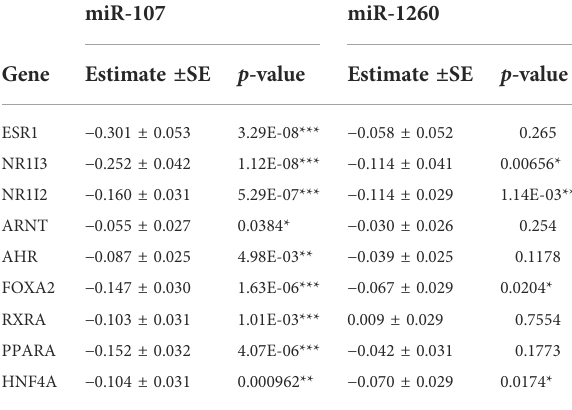
TABLE 3 Association between the expression levels of miR-107/miR- 1260 and nine transcription factors tested in this study in human liver samples ( n = 231) using linear regression analysis adjusting for covariates age, race, and